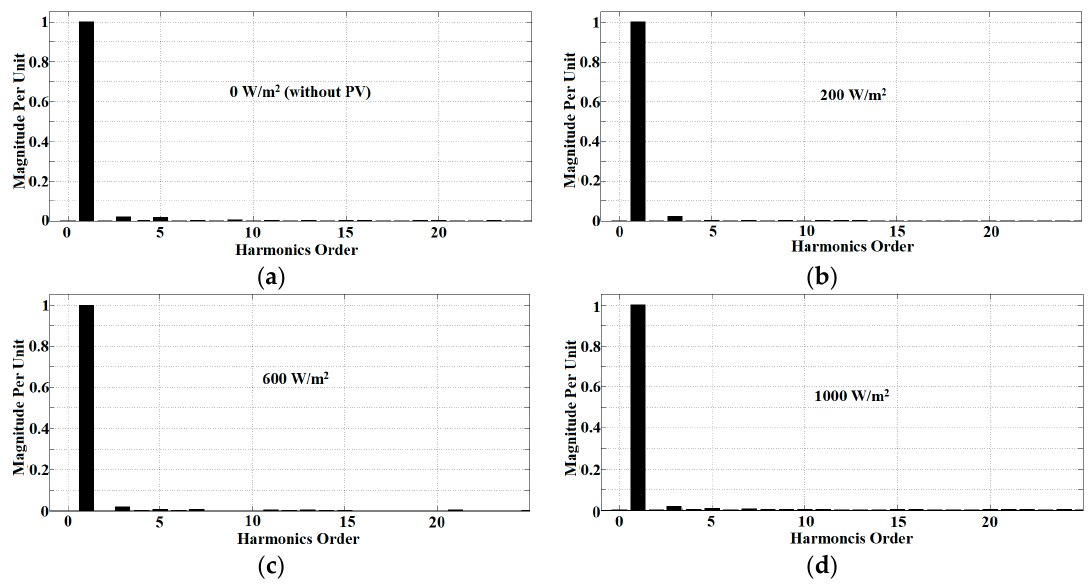
Figure 16. Experimental results of harmonic spectra for inductive load using the Simpler ADALINE algorithm at ( a ) 0 W/m 2 (without PV), ( b ) 200 W/m 2 , ( c ) 600 W/m 2 , and ( d ) 1000 W/m 2 .